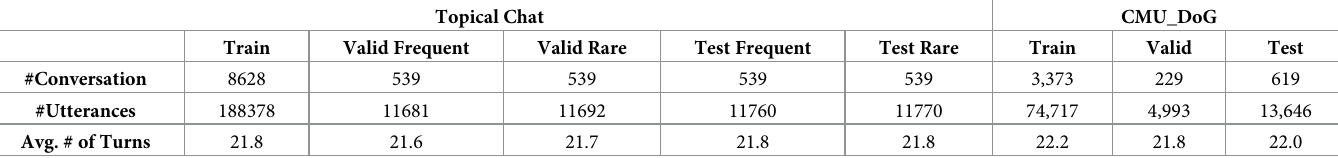
Table 3. Dataset